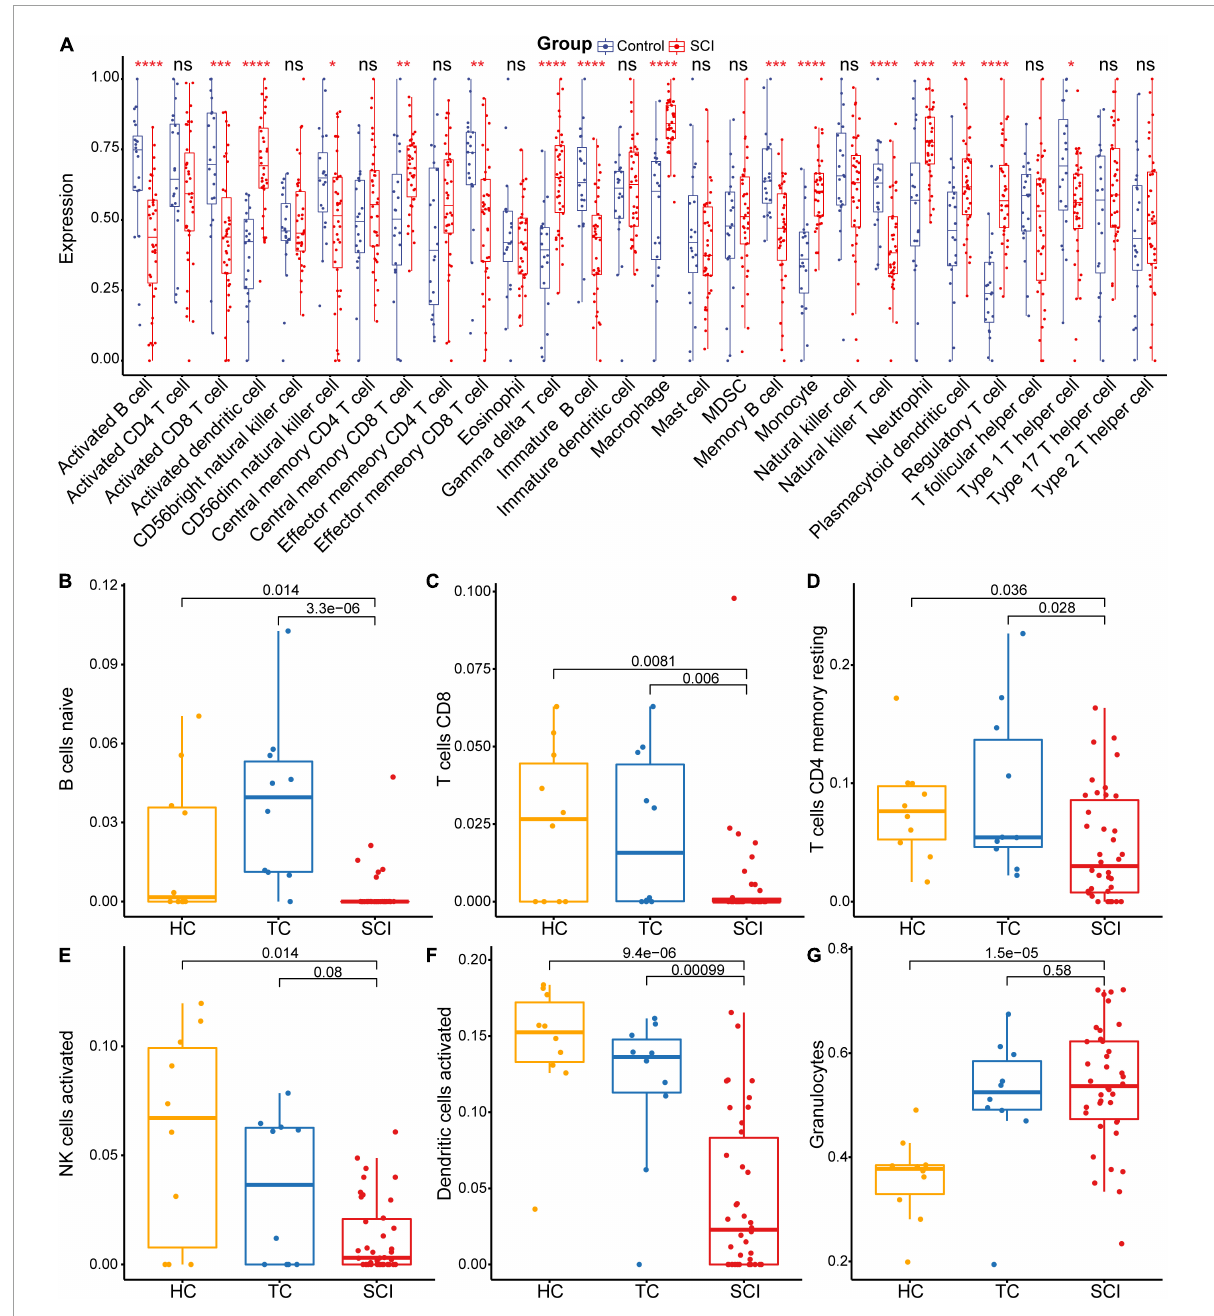
FIGURE6 Acute SCI immune infiltration analysis. (A) Differential immune cell infiltration in the experimental and control groups based on ssGSEA. “ns” indicates p ≥ 0.05, * p < 0.05, ** p < 0.01, *** p < 0.001, and **** p < 0.0001. (B–G) Differential immune cell infiltration in the experimental and control groups according to CIBERSORT analysis. The number above the box indicates the p